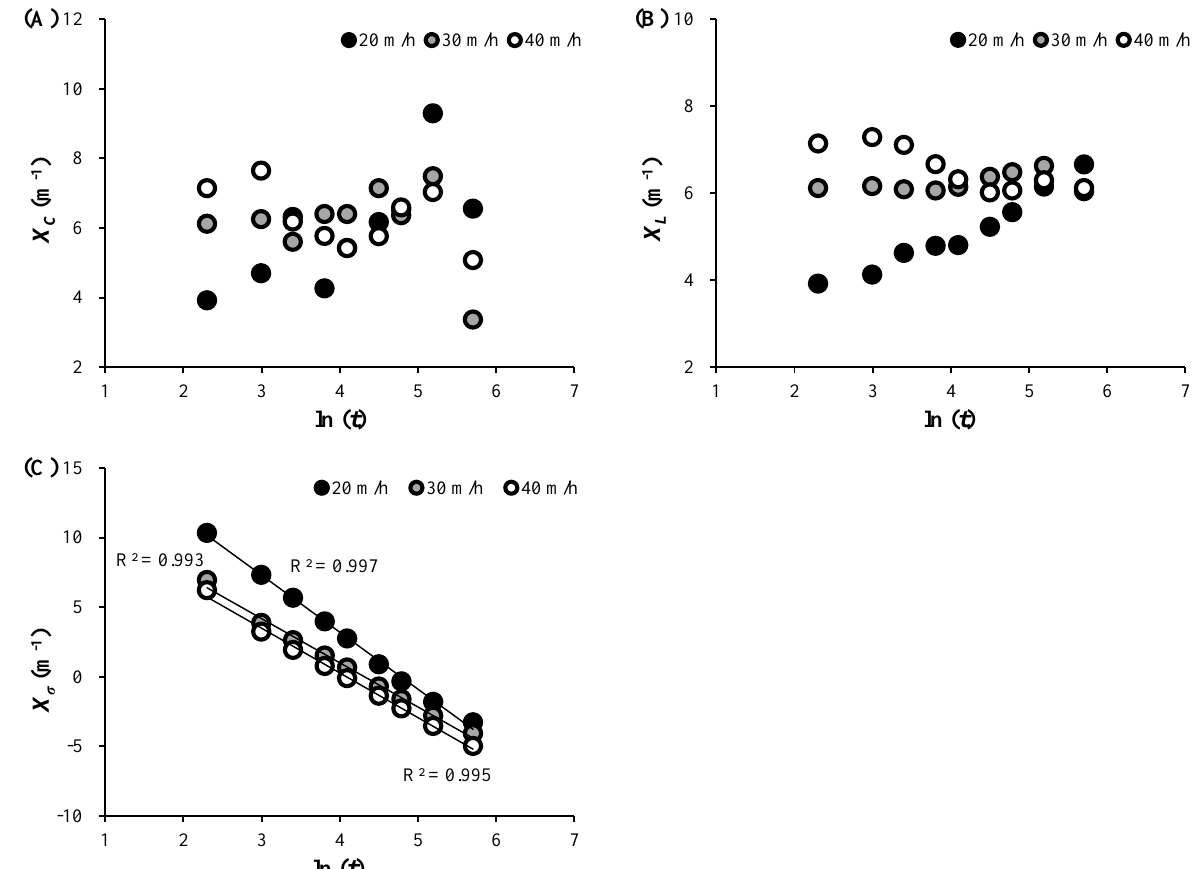
Figure 6. The time and filtration-velocity variations in the filtration coefficients of the media layer based on: ( A ) SS concentration, ( B ) SS load reduction, and ( C ) specific SS deposit.